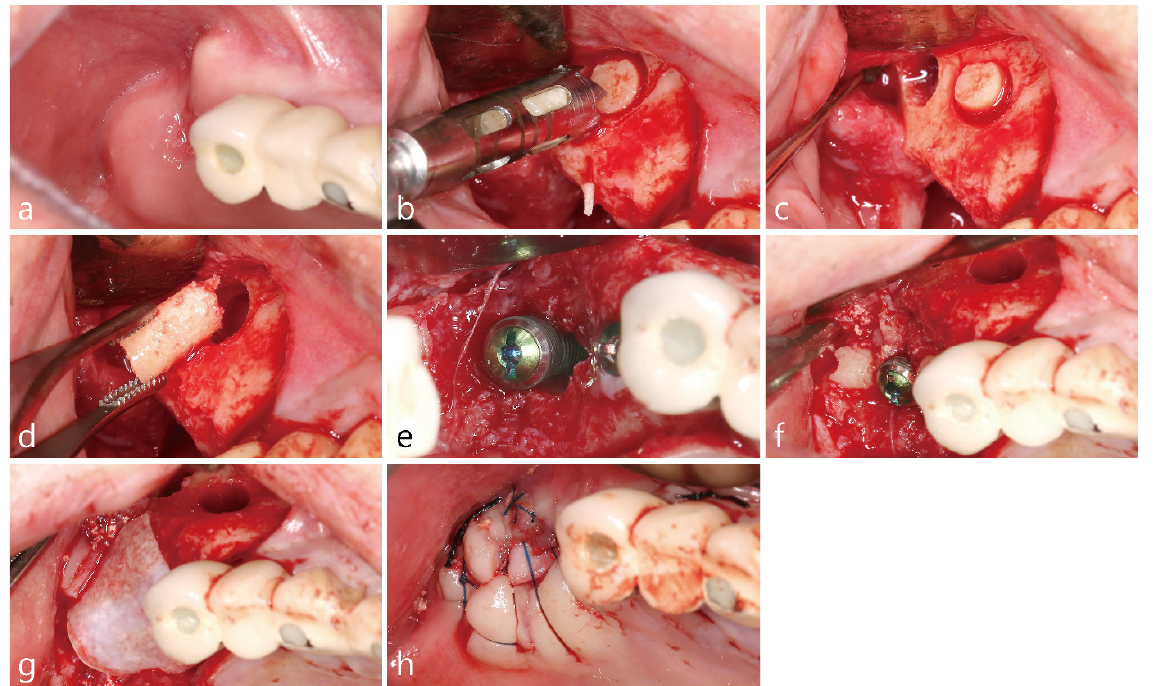
Figure 2. ( a ) Intra-oral photo of upper right maxillary quadrant 2 months post extraction ( b ) Uti- liziation of a trephine bur to collect bone from previously augmented right maxillary sinus. ( c ) Bone was harvested twice for histologic analysis and utilization for new implant site ( d ) Intra-oral photo of the size of bone core obtained. ( e ) New implant was placed in previous extraction site and the implant platform was supracrestal to the ridge to allow for vertical bone augmentation. Vertical intra-osseous defect was present on the mesial surface of the implant. ( f ) Harvested bone core was crushed and placed into the intra-osseous defect. ( g ) The surgical site was covered with an resorba- ble collagen membrane. ( h ) The flap was closed tension-free. The membrane was partially exposed at the extraction site.